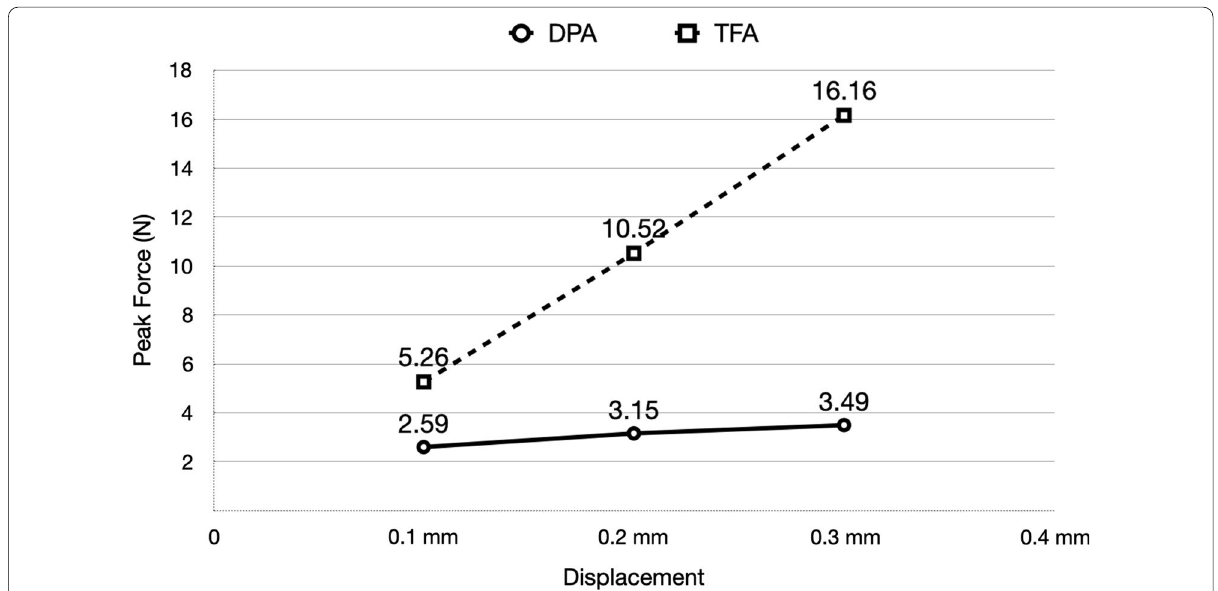
Fig. 4 Comparison of Peak Forces of TFA versus DPA